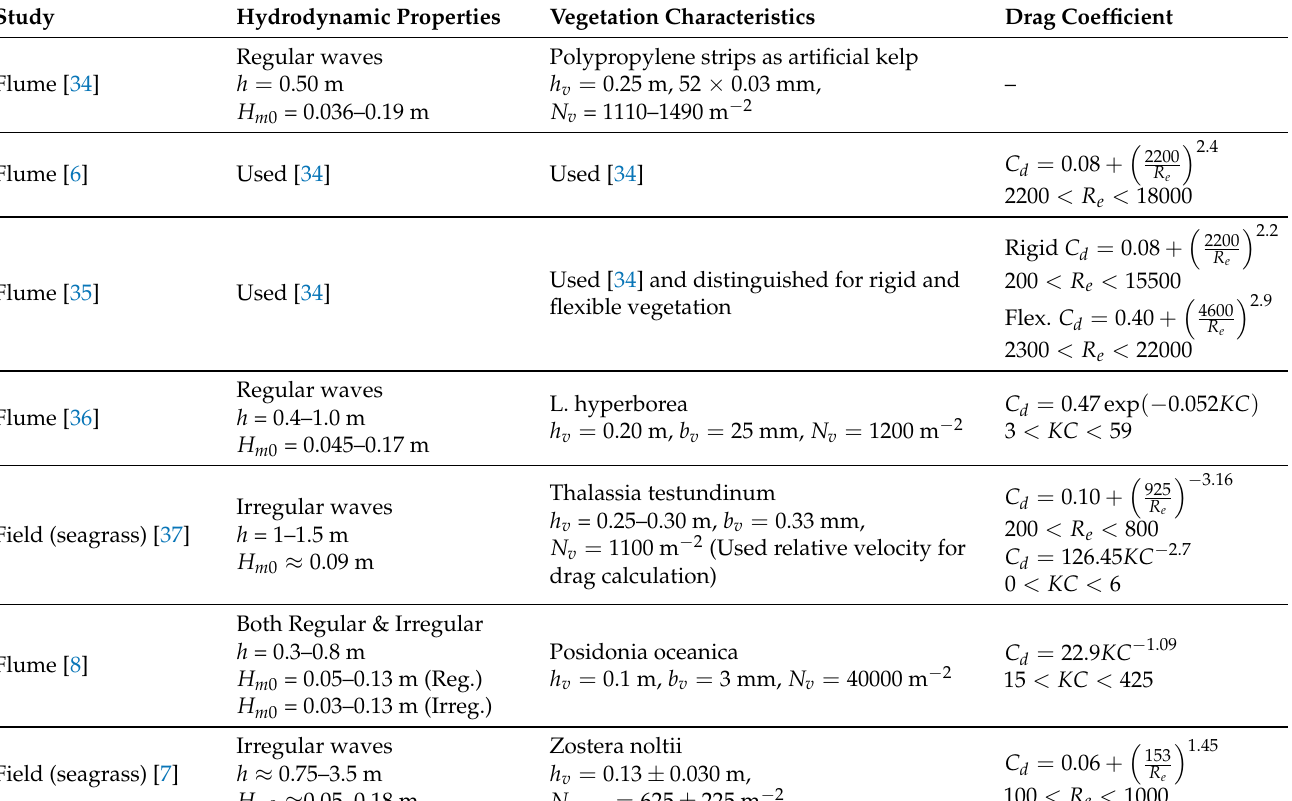
Table 1. Review of experimental work presenting variety of hydrodynamic and vegetation properties. See nomenclature for variables’ explanation. Inspired from